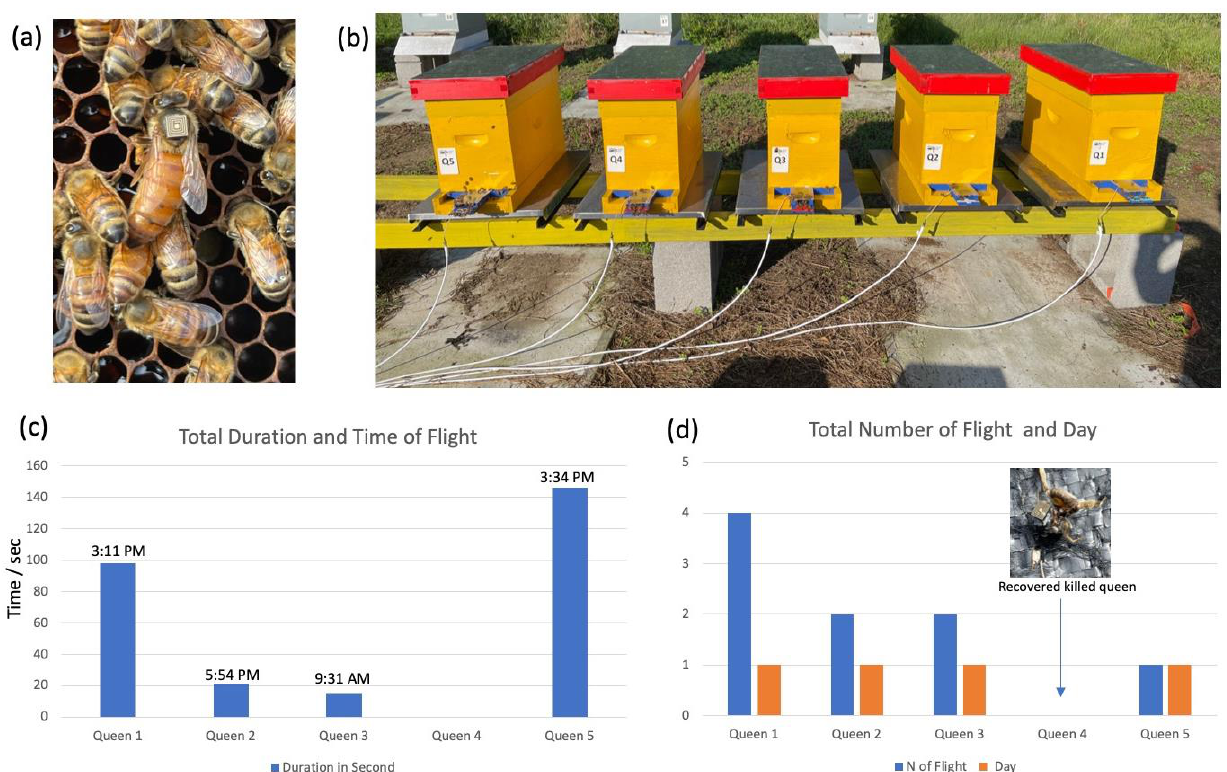
Figure 5. Description of the preliminary test conducted on queen bees. ( a ) shows honey bee queen labeled with a transponder, ( b ) five of the ten honey bee nuclei cabled to the RFID unit with tunnel and antennas at their entrance, ( c ) total time and duration of nuptial flights for each of the five virgin queens, ( d ) total number of flights and days in which they occurred. Data were collected from 20 August to 5 September 2021. The RFID unit recorded no activity related to the five other fully mated queens.